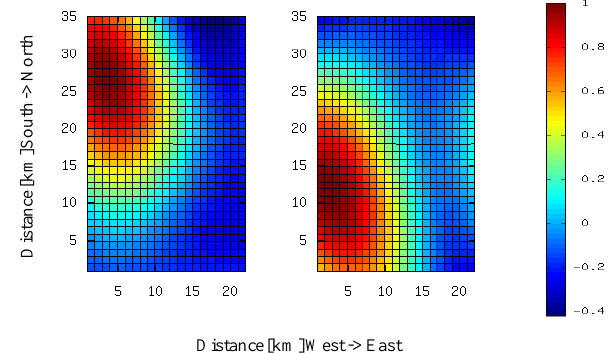
For the flow duration check at the initial time step, 0.002kg/m 2 runoff are assumed for each grid cell in the Enz catch- ment. No more runoff is assumed afterwards. The river routing model calculates the streamflow for each sub-catchment.